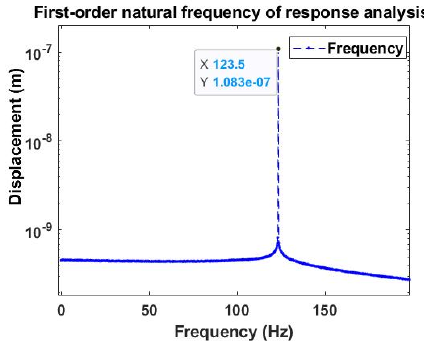
Figure 6. The curve of the harmonic response